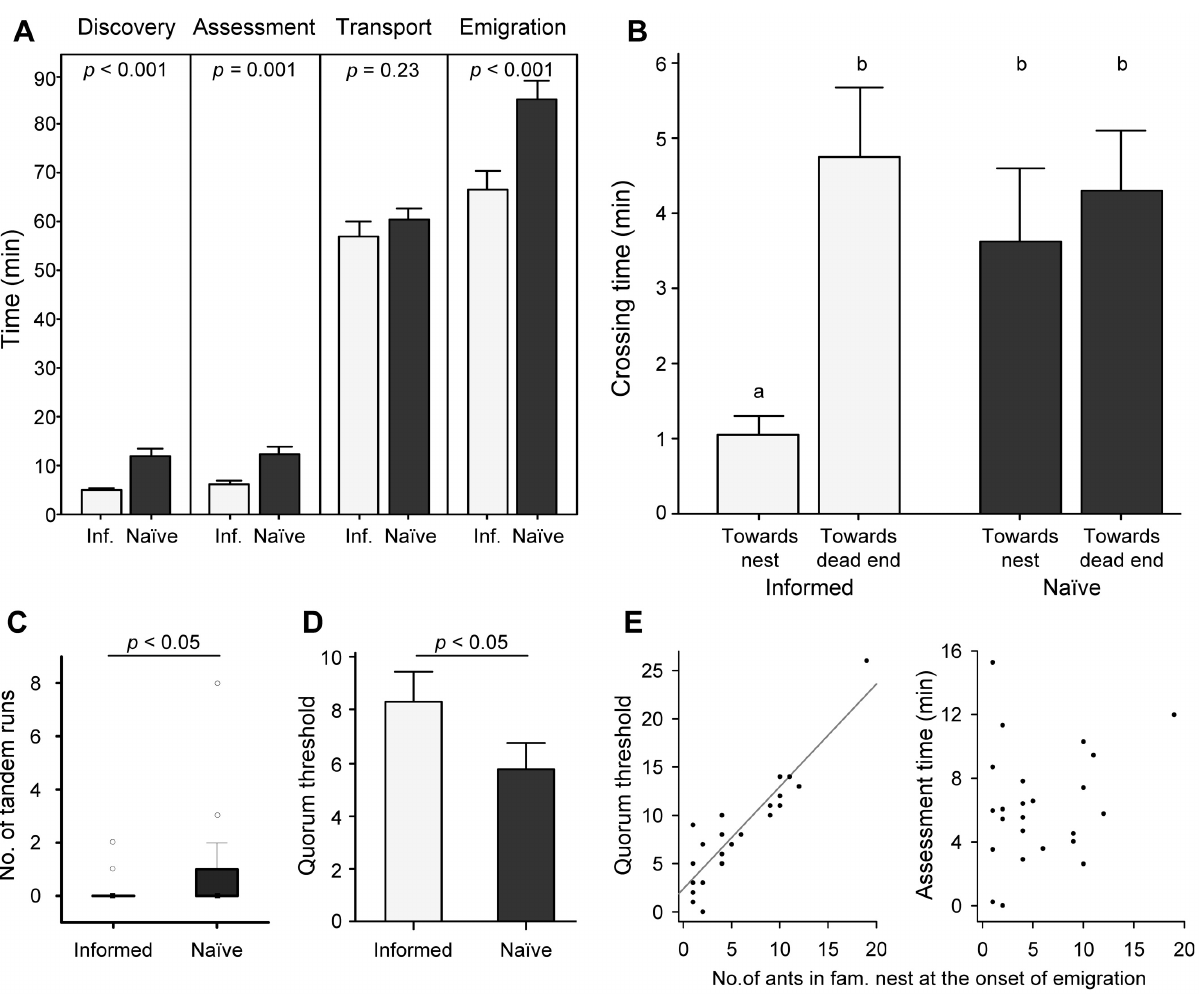
Figure 2. Prior experience and emigration speed (experiment 1). ( A–D ) Emigration data for informed (Inf., light grey, n=24) and naı¨ve (dark grey, n=24) colonies emigrating to a single good nest site (experiment 1). Bars and whiskers represent the means and standard errors, respectively (A–B, D); full squares, rectangles, whiskers and open circles represent the median, interquartile range, 1.5 x interquartile range and outliers, respectively (C). ( A ) Discovery, assessment, transport and emigration times. The effect of treatment on each variable was tested using GLMM (no data transformation). ( B ) Crossing times of intermediate dishes leading either to the new nest site or to the dead-end. Same letters indicate no statistical differences, whereas different letters indicate significant statistical differences ( p , 0.05) in LSD post-hoc comparisons (GLMM, interaction treatment/ direction: p =0.059; no data transformation). ( C ) Number of successful forward tandem runs to the new nest site (Wilcoxon matched-pairs test). ( D ) Quorum thresholds used to switch to transport. The effect of treatment on quorum threshold was tested using GLMM (no data transformation). ( E ) Relationships between the number of ants in the familiar nest at the onset of emigration and, respectively, the quorum threshold (left) or the assessment time (right) for informed colonies (n=24). Linear regression shows that these relationships are best described by the following equations: (i) Quorum Threshold =2.422 + 1.059 x No. of ants, r 2 =0.82, p , 0.001; and (ii) Assessment time =5.3 + 0.171 x No. of ants, r 2 =0.048, p =0.301. better at selecting the better option than naı¨ve colonies. Informed colonies were also marginally more cohesive than naı¨ve colonies (Figure 4B; GLMM, effect of treatment: p = 0.061).